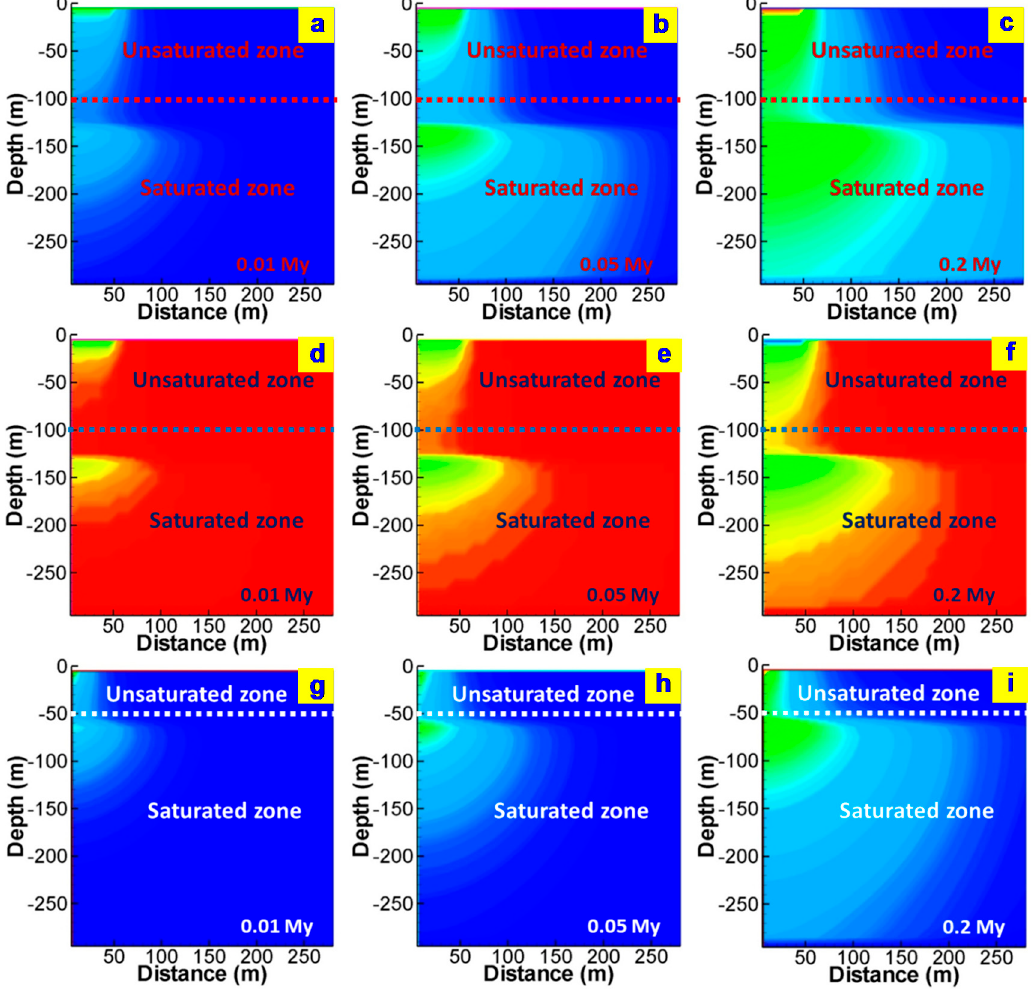
Figure 7. Calcite and dolomite content distribution after 0.01 My, 0.05 My and 0.2 My. ( a – c ) Calcite with groundwater level of 100 m; ( d – f ) Dolomite with groundwater level of 100 m; ( g – i ) Calcite with groundwater level of 50